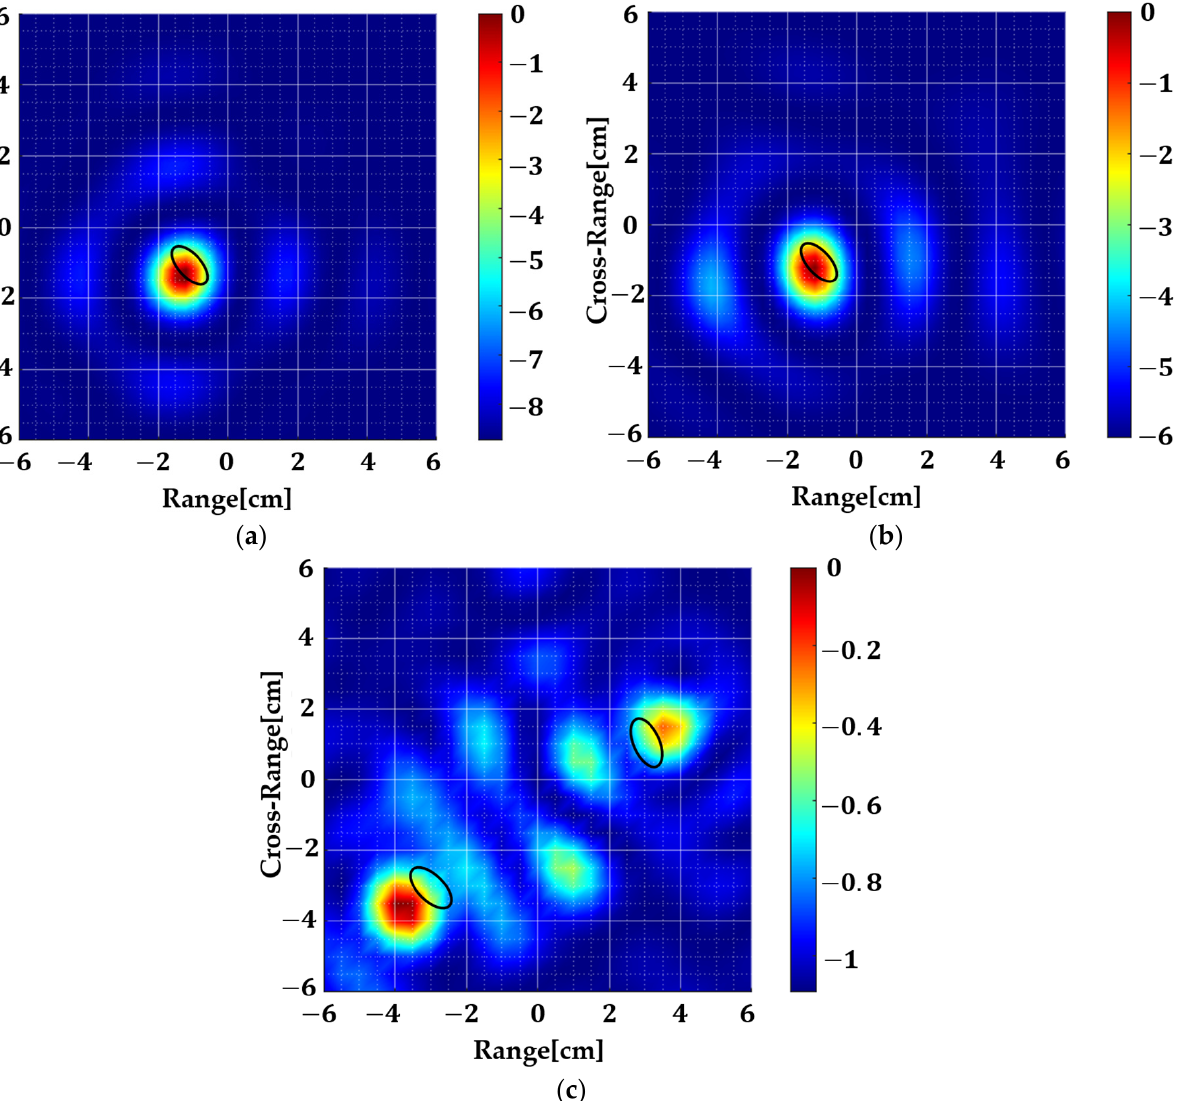
Figure 9. Analysis of the geometry shown in Figure 7 with varying contrast. The dielectric permit ‐ tivity of the target is varied ( a ) 𝜀 (cid:3047) (cid:3404) 10, 𝜀 (cid:3029) (cid:3404) 2.1, 𝜎 (cid:3047) (cid:3404) 0.24 S/m , 𝜎 (cid:3029) (cid:3404) 3 mS/m , ( b ) 𝜀 (cid:3047) (cid:3404) 3, 𝜀 (cid:3029) (cid:3404) 2.1, 𝜎 (cid:3404) 0.24 S/m, 𝜎 (cid:3404) 3 mS/m , and ( c ) 𝜀 (cid:3047) (cid:3029)